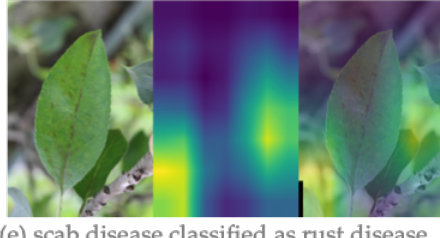
Figure 4. Misclassified pictures on field datasets obtained from MobileNetV2, InceptionV2, and EfficientB0. In each photo, from left to right, we see the original image, the generated heatmaps of the last convolution layer, and the overlap of the two images. The first column shows the errors for the RoCoLe dataset, whereas the second column depicts the error for the Plant Pathology